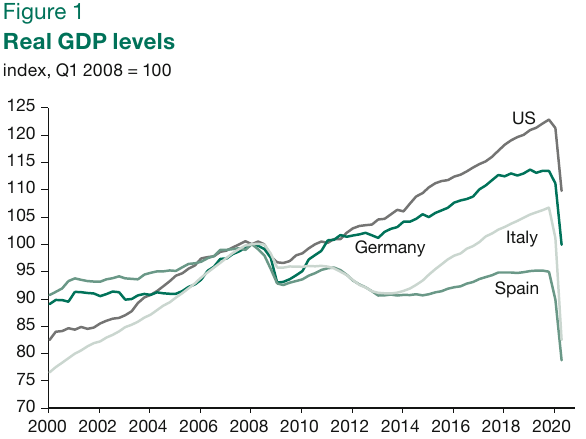
Real GDP levels